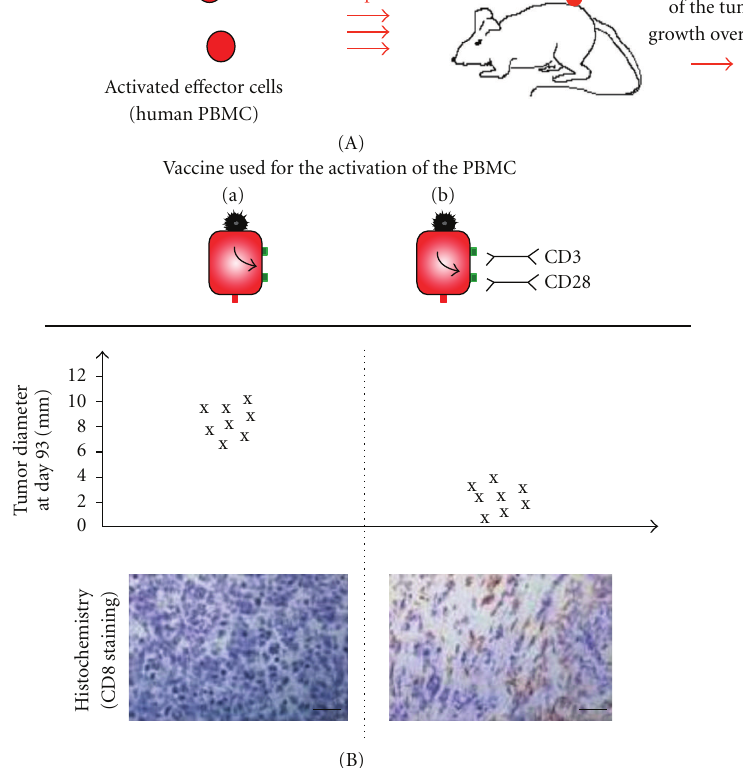
receptor 3 (TLR-3) [48]. This promotes cross-priming of T cells to virus-infected cells